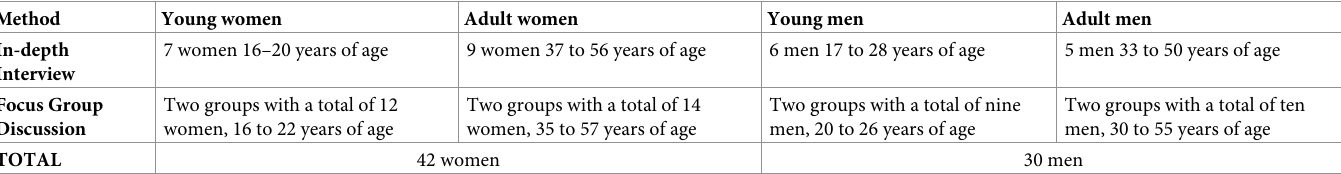
Table 1. Overview of research participants and the data-collection